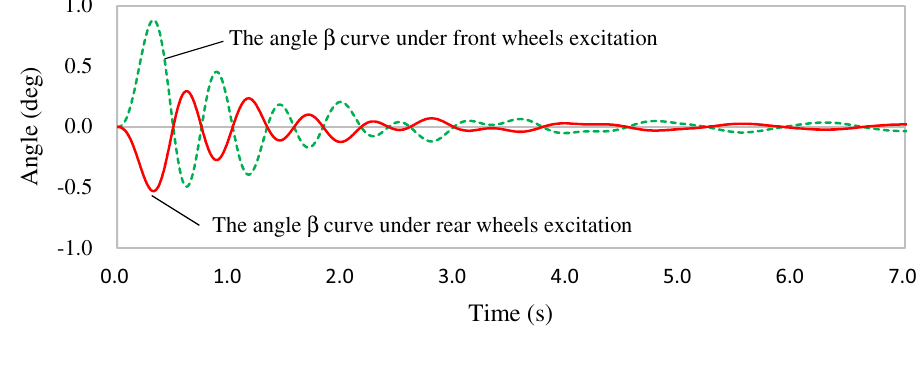
Fig. 8 The pitching angle test